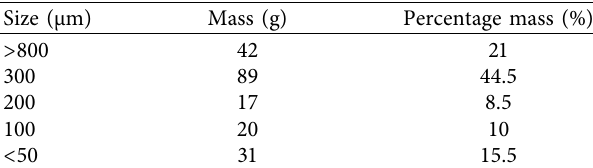
Table 2: Particle size distribution of